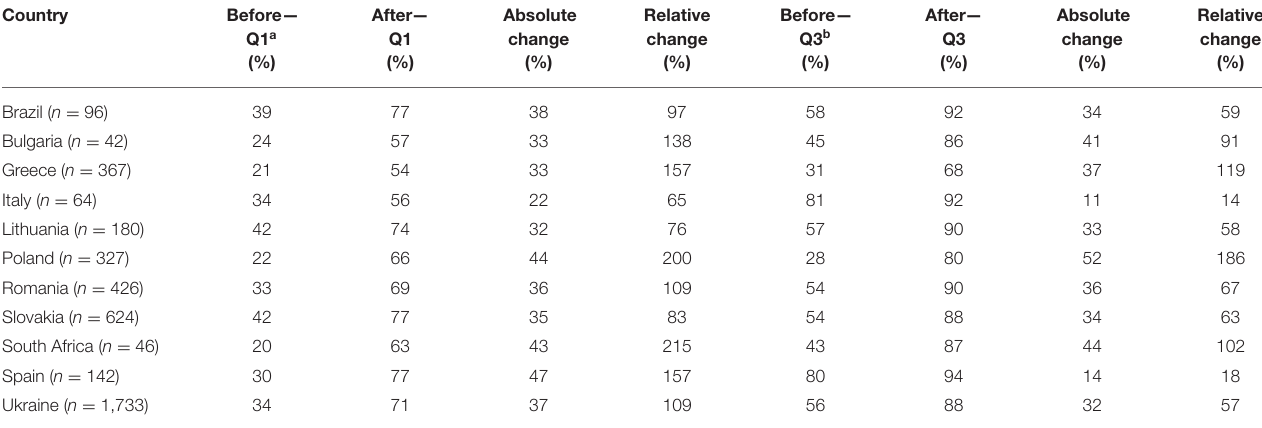
TABLE 3 | Country breakdown of percentage of respondents who indicated the correct course of action for all three stroke symptoms in question 1 and 3- in parental group 1 (who responded to the SPQ in t1 and t2).